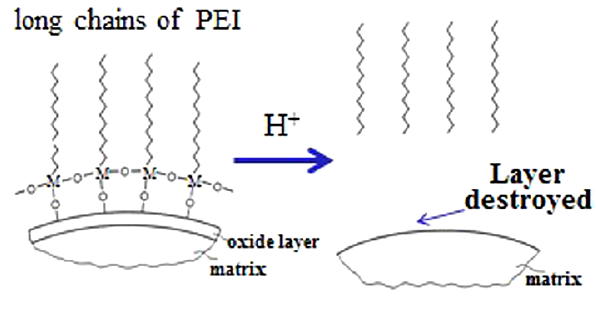
Figure 4. Adsorption and desorption mechanism of PEI on the powder